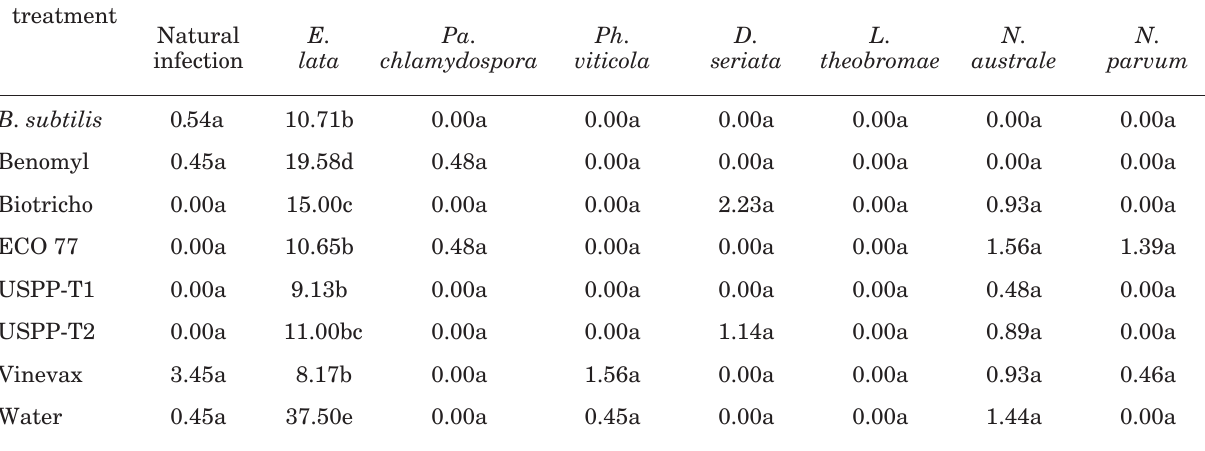
Table 3. Mean incidence of Eutypa lata that was isolated from pruning wounds 8 months after the fresh pruning wounds were treated with benomyl, Bacillus subtilis , two Trichoderma spp. (USPP-T1 and -T2), three commercial Trichoderma -based biocontrol products or water as pruning wound protectants, and challenged 7 days later by spray- inoculation with Eutypa lata , Phaeomoniella chlamydospora , Phomopsis viticola , Diplodia seriata , Lasiodiplodia theobromae , Neofusicoccum australe and N. parvum spore suspensions, or sprayed with sterile water to evaluate natural